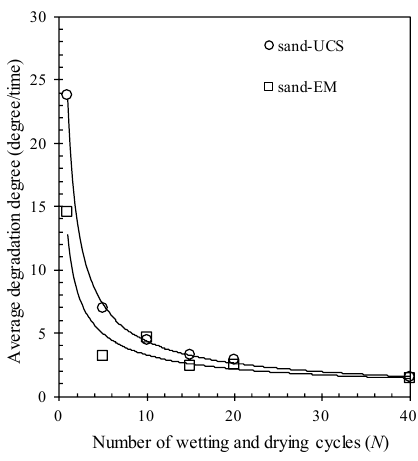
Figure 12. Average degradation degree of UCS and EM of sandstone after wetting-drying cycles ( UCS represents uniaxial compressive strength, EM represents elastic modulus).